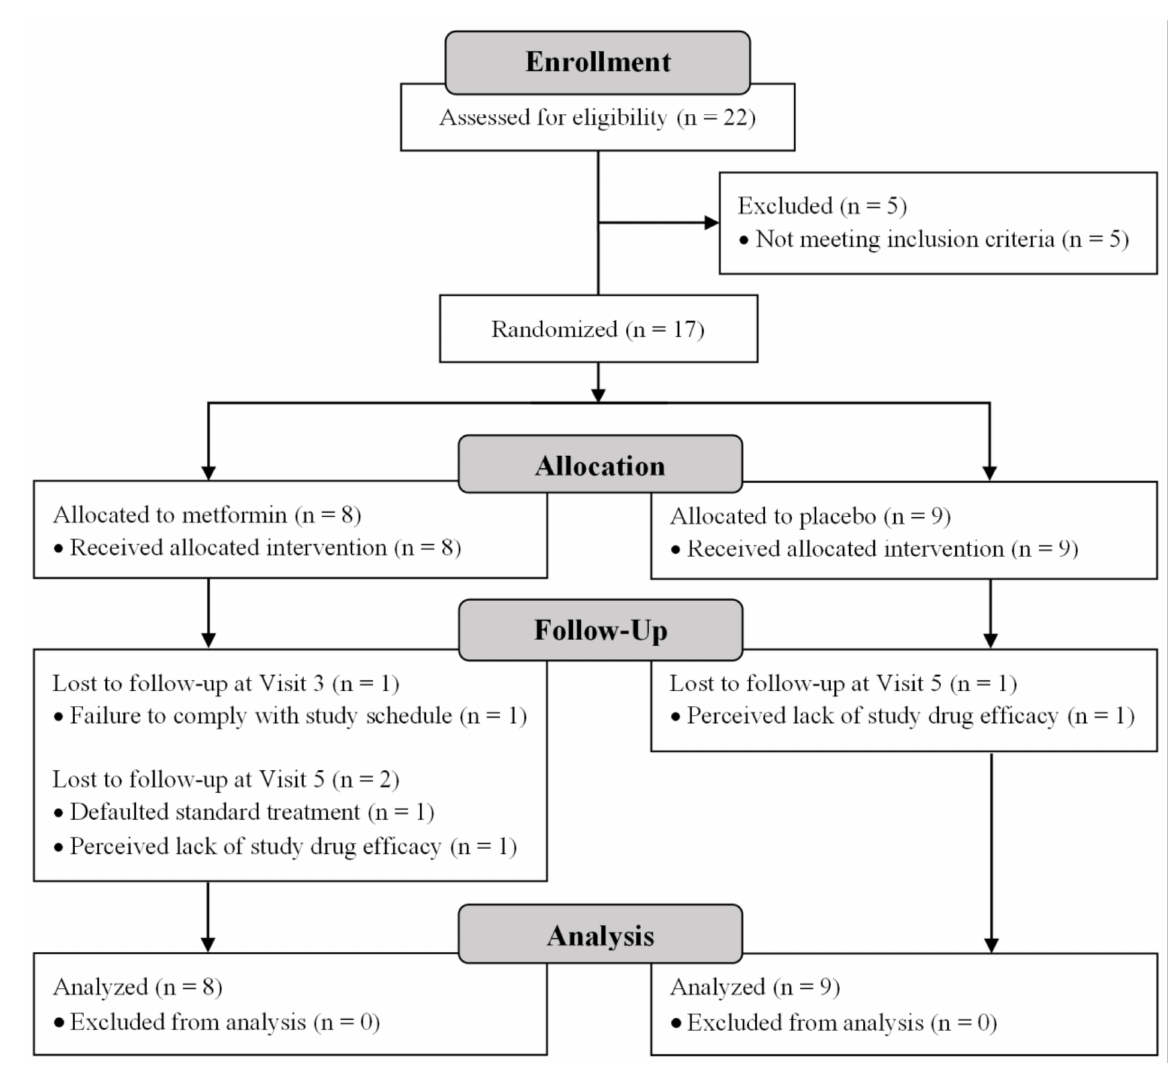
Figure 1. CONSORT diagram of participant